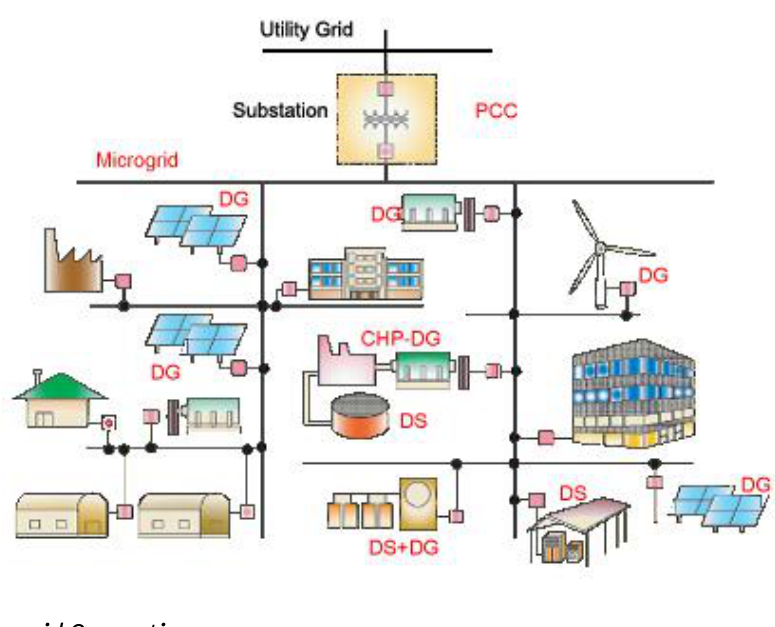
Figure 1. Microgrid